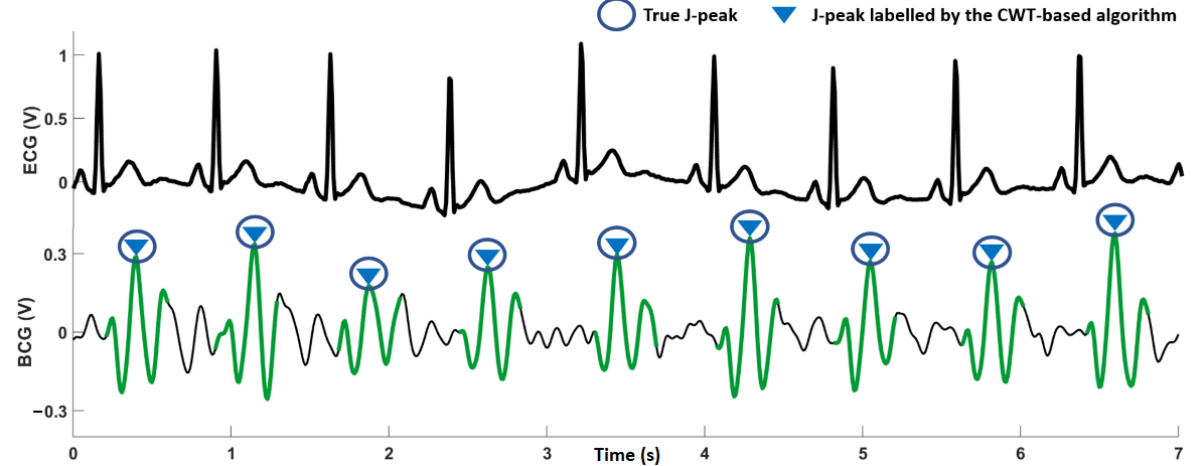
Figure 7. Seven seconds of electrocardiography and ballistocardiography (BCG) recordings for participant 6. The BCG signal is clean, and the algorithm is able to detect all J-peaks correctly. BCG: ballistocardiography; CWT: continuous wavelet transform; ECG: electrocardiography.